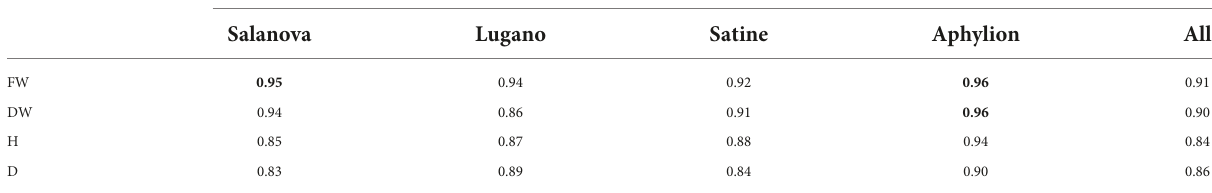
TABLE 5 Correlation between LA and other traits of different lettuce varieties.